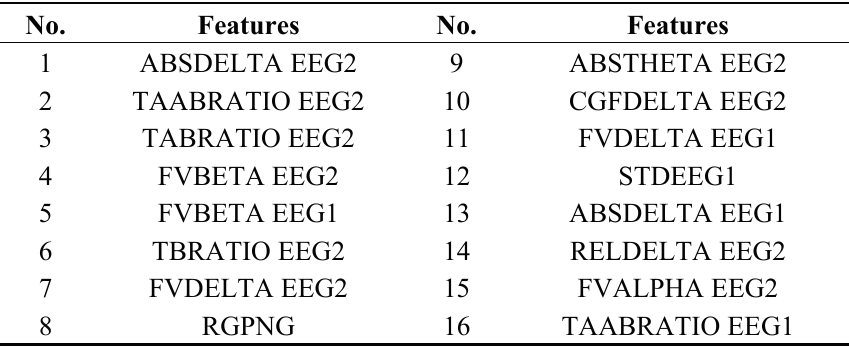
Table 4. Sixteen most descriptive features obtained by